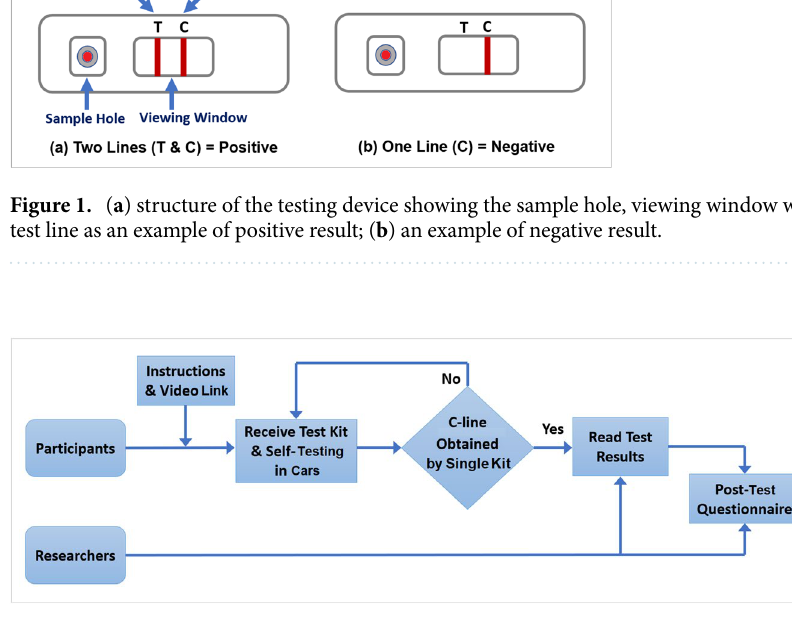
Figure 2. The diagram for the study